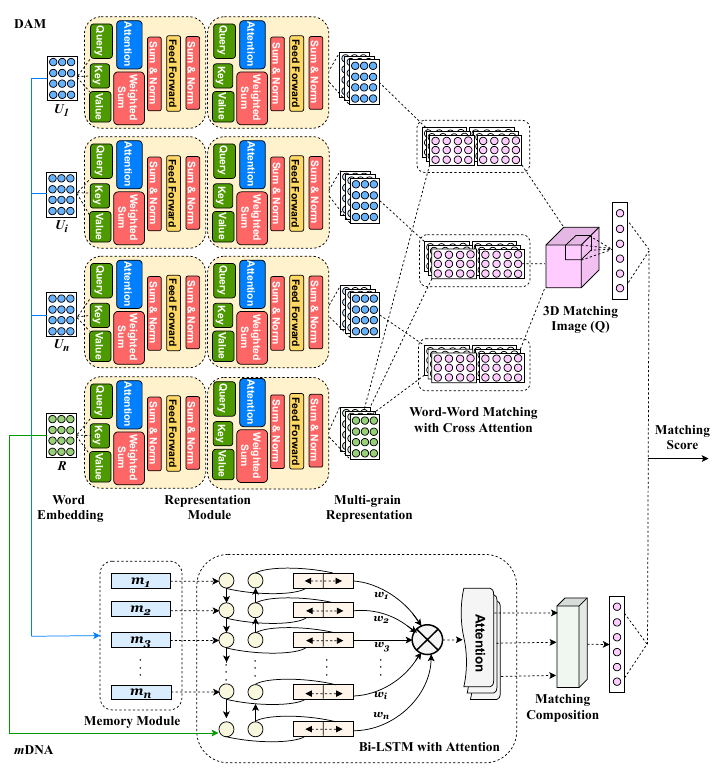
Figure 2. An overview of the combined architectures of DAM and